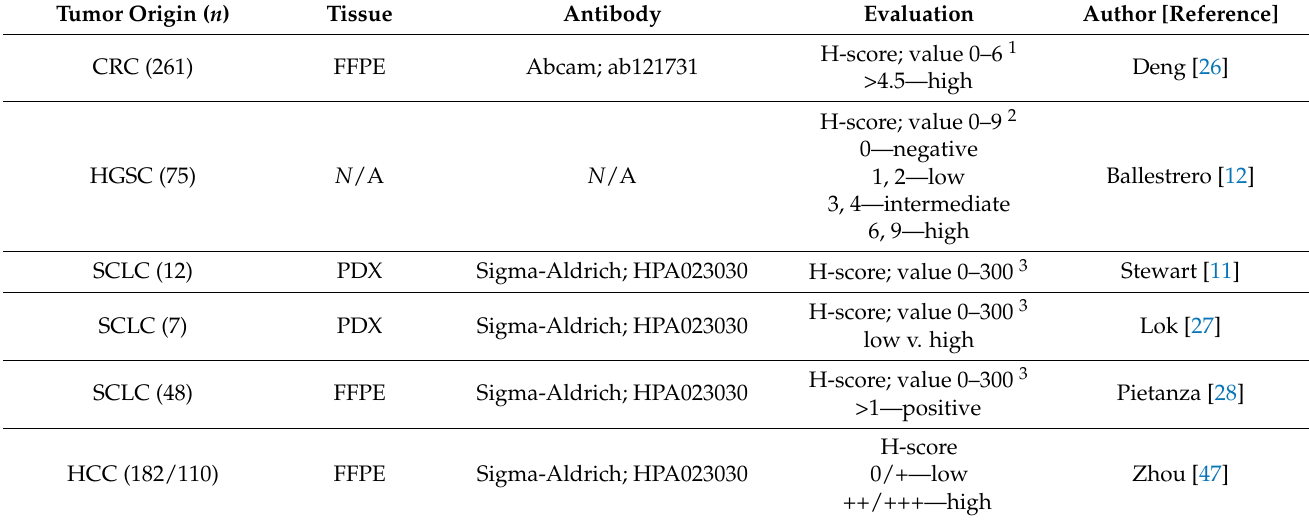
Table 2. Summary of methodologies used for the immunohistochemical analysis of SLFN11 expres- sion in different